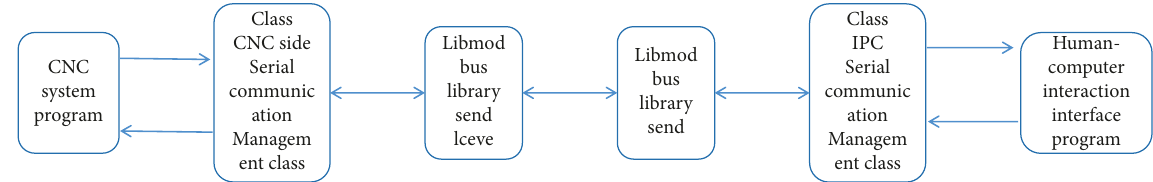
Figure 14: The realization process of communication between a CNC system and an industrial computer.